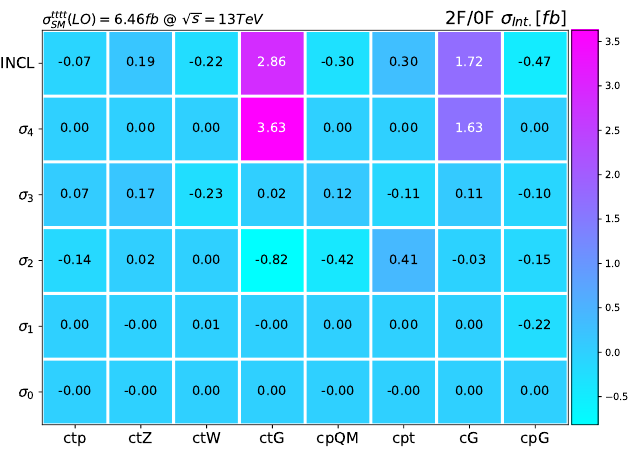
Figure 6 . Same as figure 4 but for the contributing operators (see eq. (3.1)).